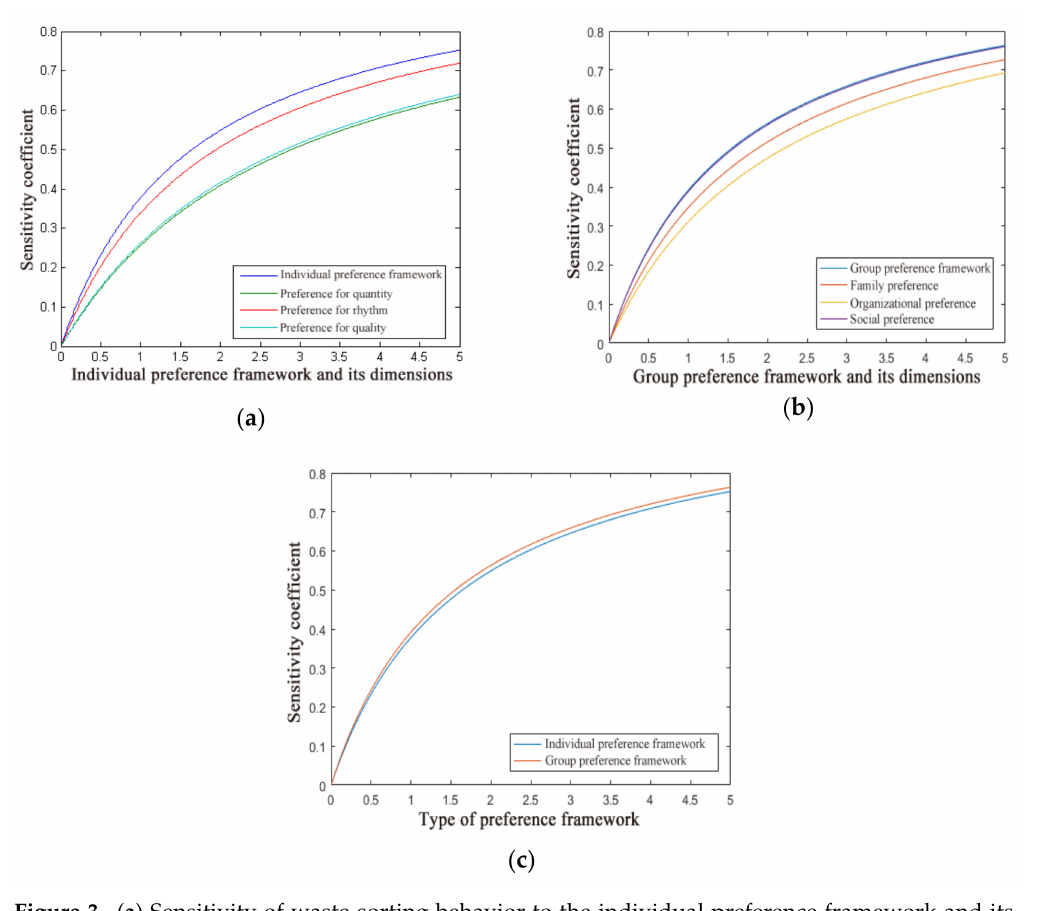
Figure 3. ( a ) Sensitivity of waste-sorting behavior to the individual preference framework and its dimensions; ( b ) sensitivity of waste-sorting behavior to the group preference framework and its dimensions; ( c ) sensitivity of waste-sorting behavior to the individual preference framework and the group preference